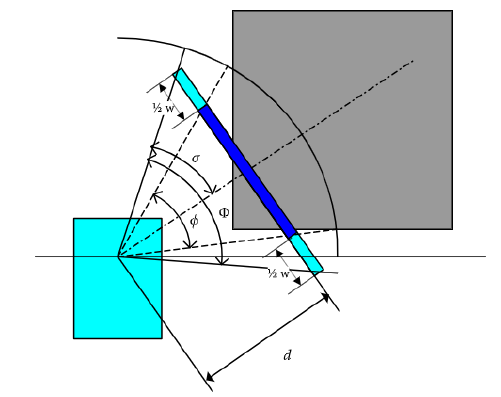
Figure 4. Enlarging the angle occupied by